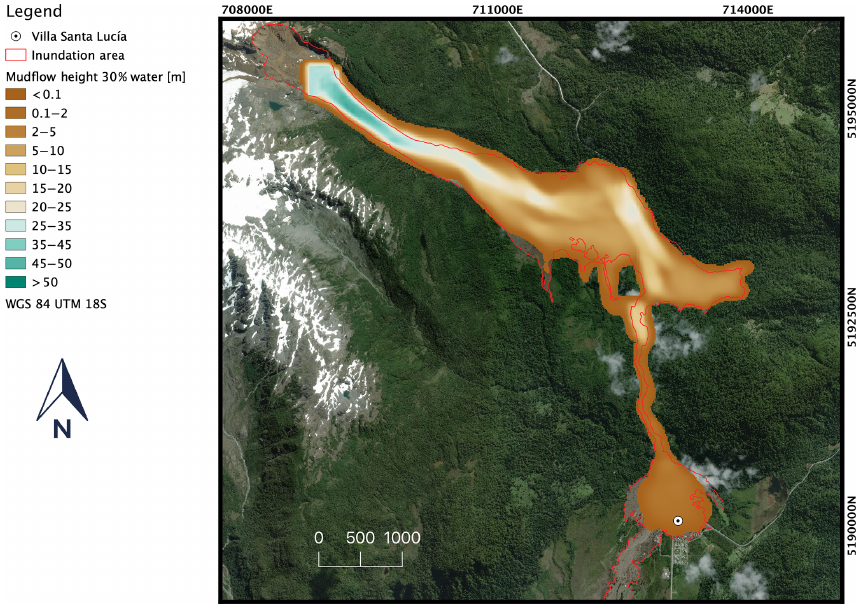
Figure 10. Simulation results using the calibrated parameters for r.avaflow and 30% water content (background © ESRI).